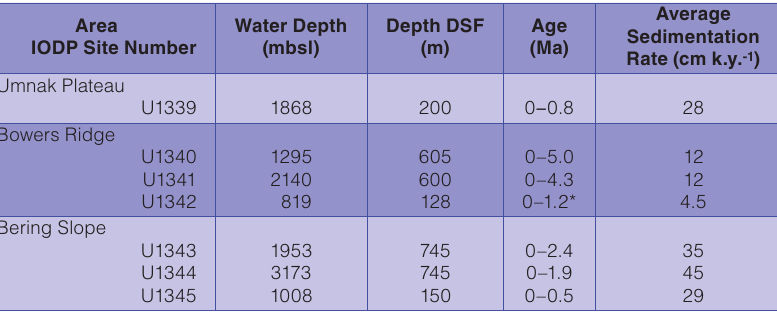
Table 1. Summary of drilled results for IODP Exp 323 in the Bering